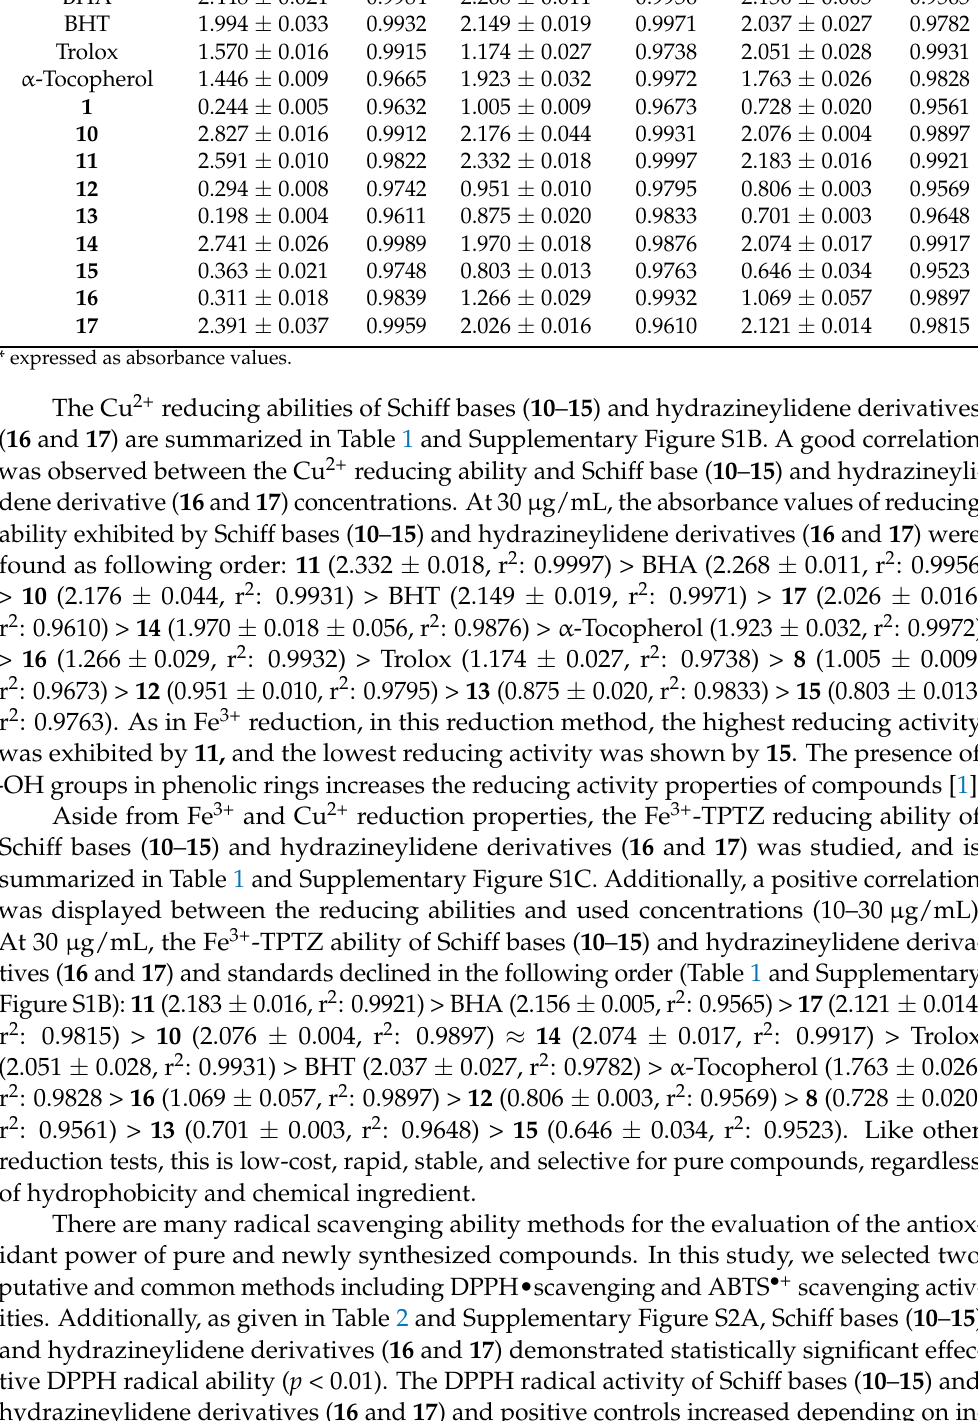
Table 1. The reducing ability of 30 µ g/mL of Schiff bases ( 10 – 15 ) and hydrazineylidene derivatives ( 16 and 17 ) through Fe 3+ -TPTZ, Fe 3+ , and Cu 2+ reducing methods. Fe 3+ Reducing Cu 2+ Reducing Fe 3+ -TPTZ Reducing Antioxidants λ 700 * r 2 λ 450 * r 2 λ 593